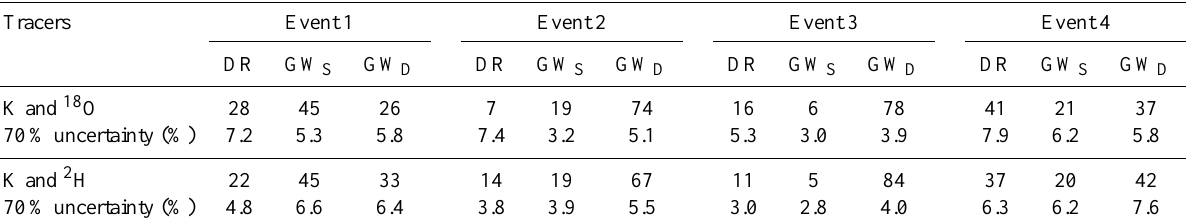
Table 6. Direct runoff (DR), shallow groundwater (GW S ), and deep groundwater (GW D ) contributions in % and 70% uncertainty of three- component hydrograph separations in %.